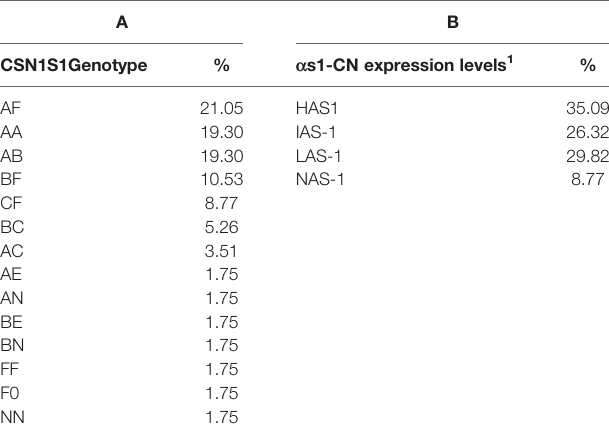
TABLE 2 | CSN1S1 genotype (A) and a s1-casein (CN) expression levels (B) distribution in the Garganica goat population.